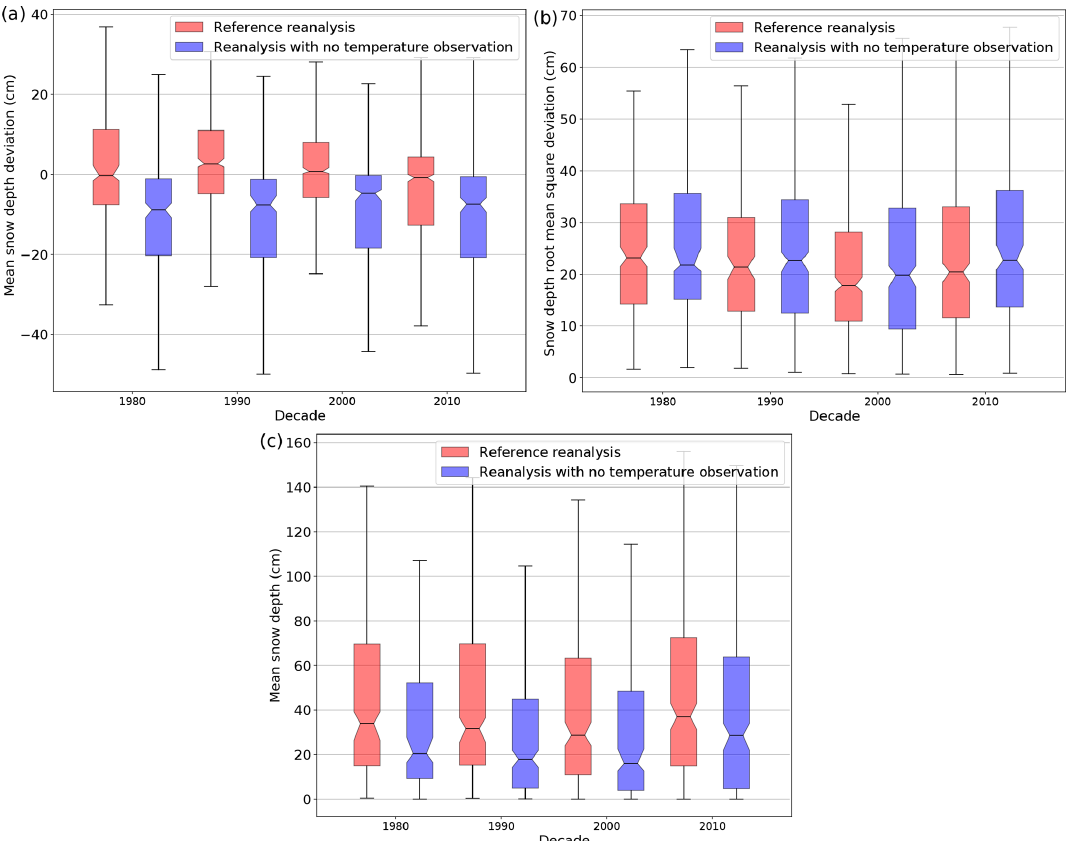
Figure 15. Mean deviation (a) and root mean square deviation (b) between the simulated and observed snow depth values and mean simulated snow depth (c) for the four decades between 1980 and 2020 for the S2M reanalysis and the simulation with no 2m temperature observation assimilated (see Sect.